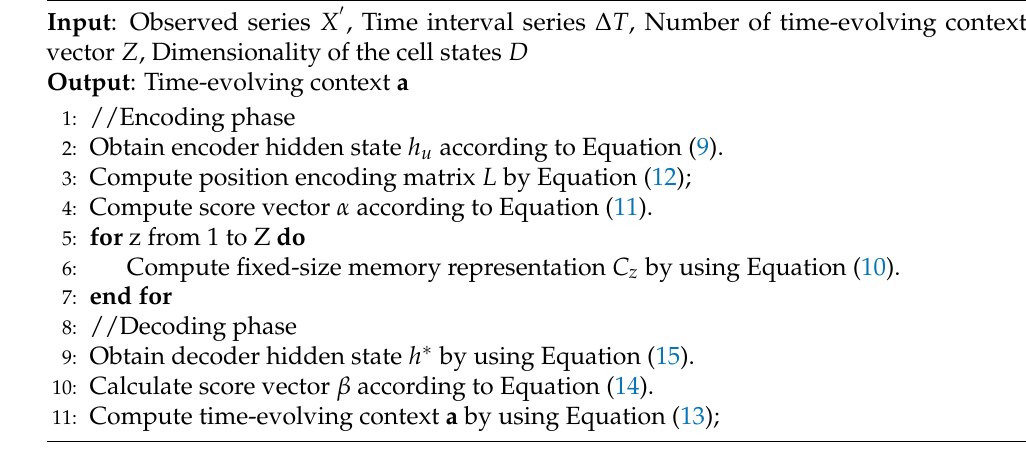
Algorithm 1 Time-evolving context vector